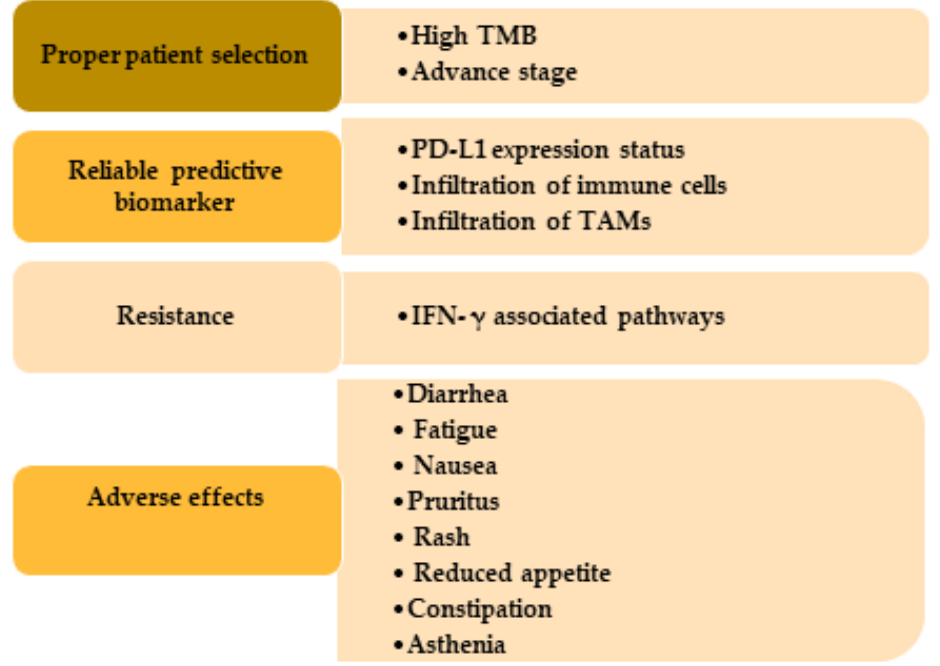
Figure 3. Challenges usually occur in the immunotherapy treatment in SCC patients. Patients with high TMB and advanced or metastatic stage get more benefit from immunotherapy. Expression of PD-L1, immune cells, and TAMs are useful as biomarkers. IFN- γ causes immunotherapy resistance through PD-L1-dependent or -independent pathways and by producing adenosine deaminase acting on RNA 1 and yes-associated protein. TMB, tumor mutational burden; PD-L1, programmed cell death-ligand 1; TAMs, tumor-associated macrophages.